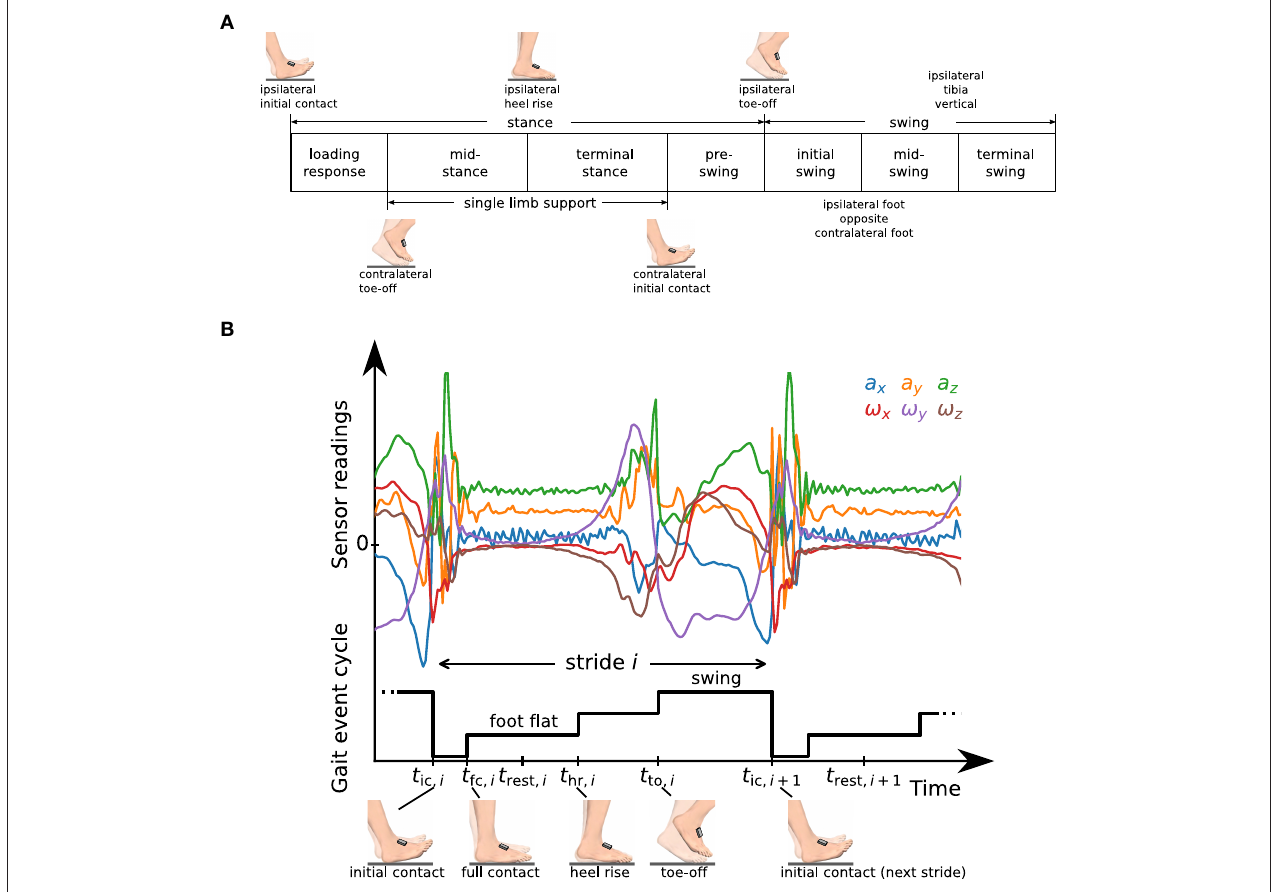
FIGURE 3 | (A) Definition of gait phases as used in standard literature [cf. (44)], and transitions based on gait events of the ipsilateral and contralateral foot. (B) Raw accelerometer and gyroscope sensor readings and representation of the gait event cycle with a staircase-shaped signal. We define time instants t ic, i , t fc, i , t hr, i , t to, i that mark characteristic events and a rest instant t rest, i in the middle of the phase in which the foot is fully on the ground (foot